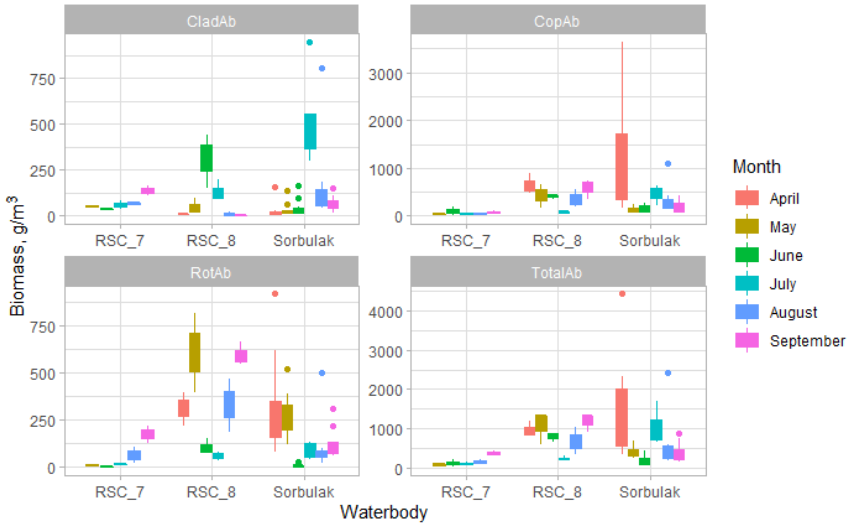
Figure 8. Dynamics of the zooplankton biomass in wastewater reservoirs of the Right-Bank Sorbu- lak Canal system during six warm months of 2021.